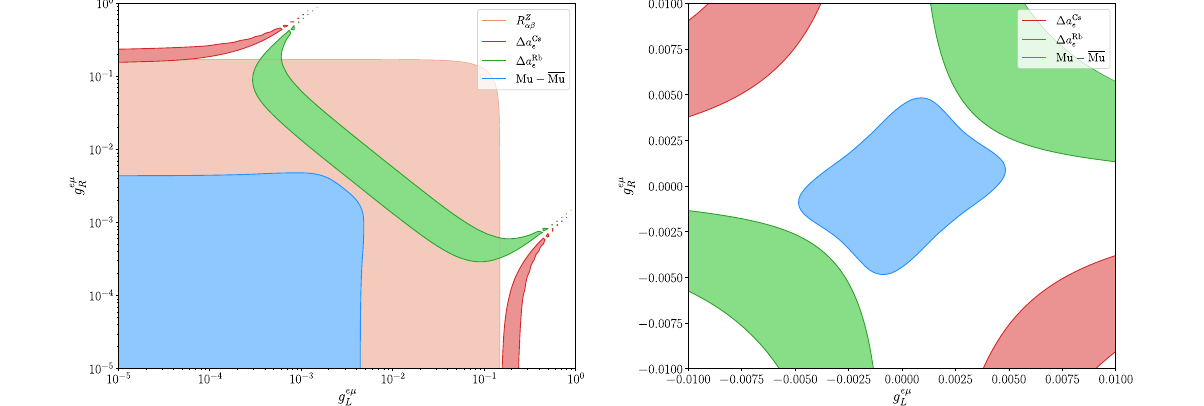
orange) and Muonium oscillations (blue); the red and the green regions respectively denote the 1 σ ( g − 2 ) Cs e and ( g − 2 ) Rb e favoured regimes. On the right, detailed (linear) view of the viable g e